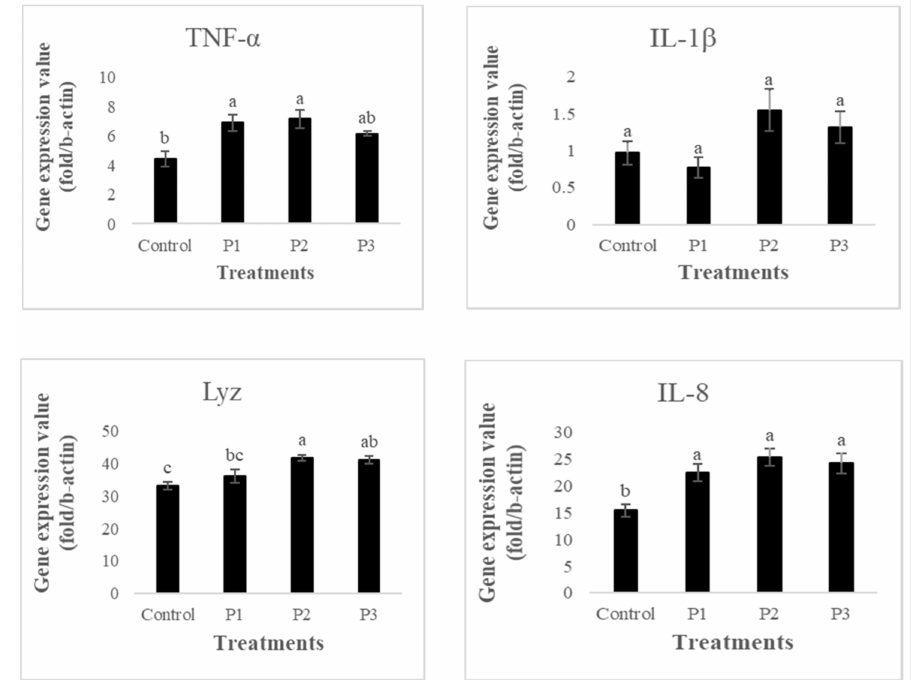
Figure 5. The relative expression of immune related genes, TNF- α , IL-1 β , Lyz, and IL-8, in head kidney of rainbow trout fed four experimental diets with different inclusion levels control: 0, P1: 5, P2: 10, and P3: 20 g of apple pomace derived pectin (APDP) for 30 days. Values are presented as the mean ± SE. ( n = 9). Different letters (a–c) in each row indicate significant differences ( p <